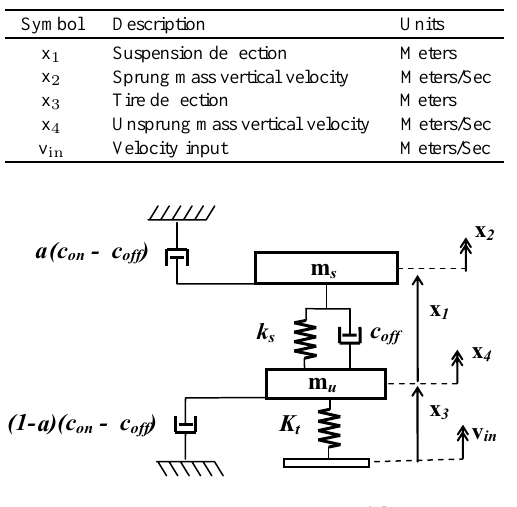
Fig. 1. Quarter-car 2-DOF